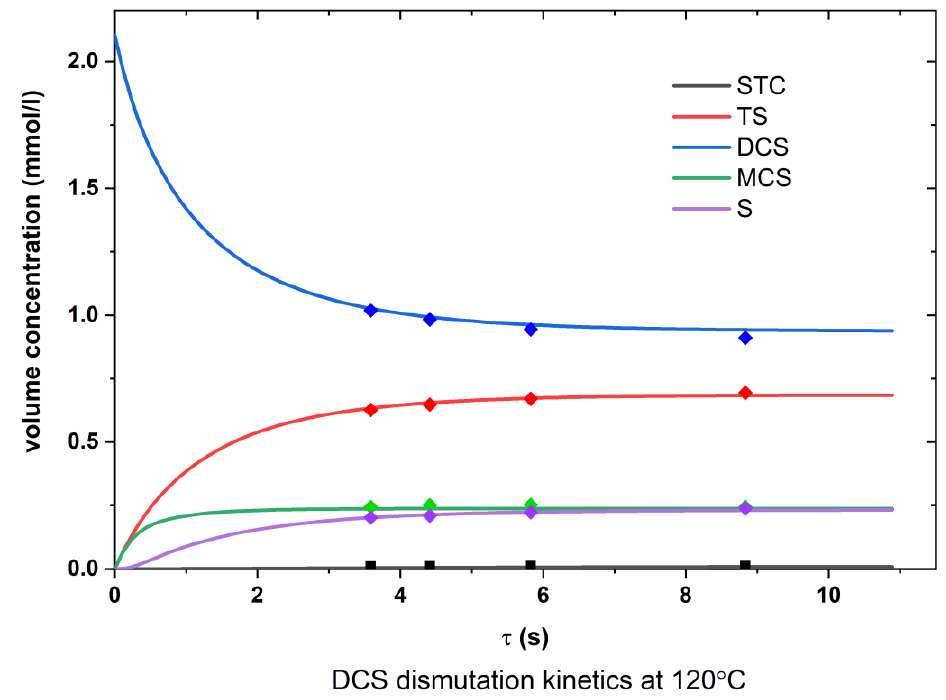
Figure A5. Dependence of the molar concentrations of chlorosilanes on time (DCS, 100 °C).